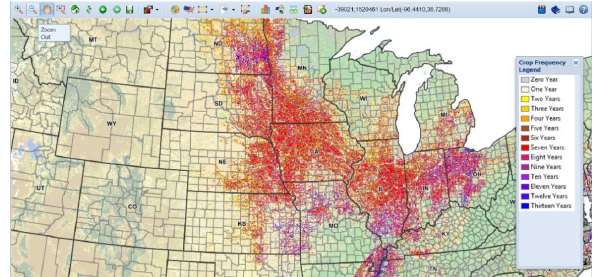
Figure 1. Density map of soybean of the U.S. CONUS region.